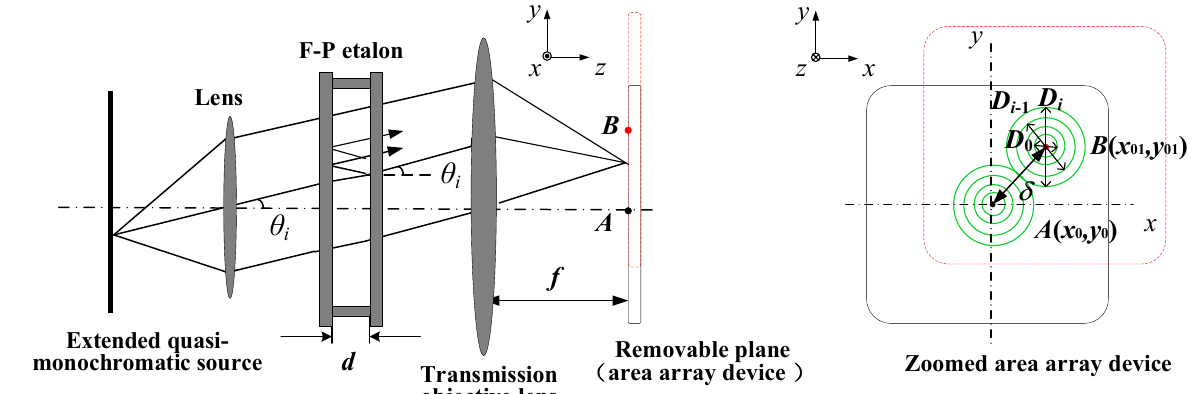
Figure 1. Interference imaging principle of F-P etalon.